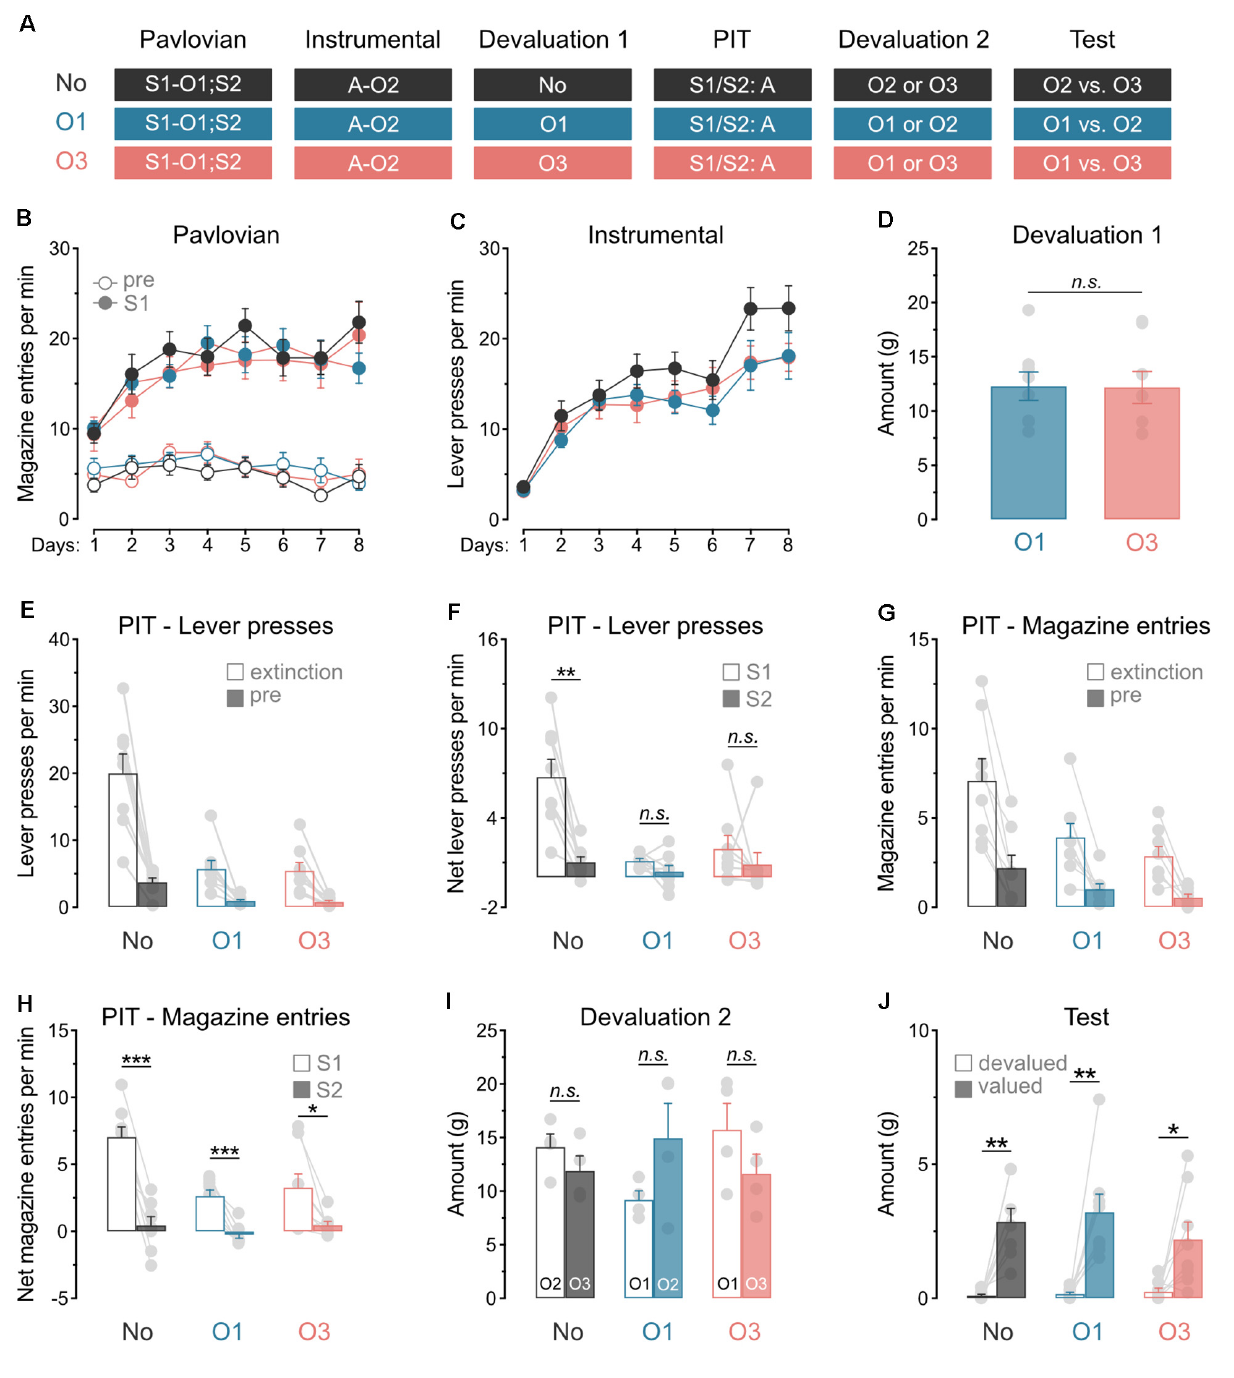
FIGURE 1 | Satiety alone abolishes general PIT. (A) Design of the first experiment; S1/S2: clicker or noise stimuli (counterbalanced); O1/O2/O3: grain, purified, or chocolate pellets outcomes (counterbalanced); A: left lever press action. (B) All rats learned that stimulus S1 predicted food outcome O1. (C) All rats learn to perform the left lever press action A to earn food outcome O2. (D) During outcome devaluation via sensory-specific satiety, rats in groups O1 and O3 consumed an equivalent amount of O1 and O3, respectively. (E) Outcome devaluation reduced lever press responding during the extinction and baseline (pre) period of the general PIT test. (F) Outcome devaluation abolished general PIT in groups O1 and O3. (G) Outcome devaluation reduced magazine entries during the extinction and baseline (pre) period of the general PIT test. (H) Although magazine entries were reduced after outcome devaluation, all groups showed higher magazine entries in the presence of S1. (I) During the second outcome devaluation via sensory-specific satiety, rats consumed an equivalent amount of the various outcomes. (J) All rats ate more of the valued outcome than the devalued outcome. Data are shown as mean ± SEM. Asterisks denote significant effect (* p < 0.05; ** p < 0.01; *** p < 0.001). n.s.,